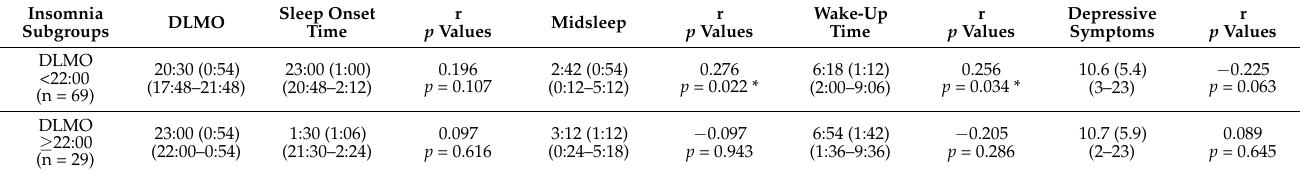
Table 2. Correlations between subgroups of participants depending on their DLMO times, before and after 22:00 with sleep diary variables (onset, midsleep, and wake-up time) and depressive symptoms. DLMOs, sleep variables, and depressive symptoms are shown as averages (SD) and (range). The symbol * indicates statistical significance.